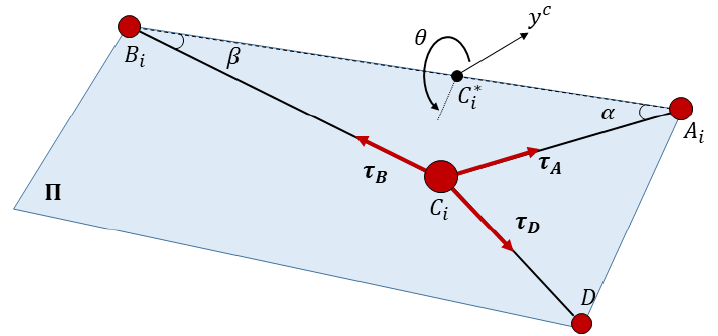
Figure 6. Equilibrium of forces in point C i